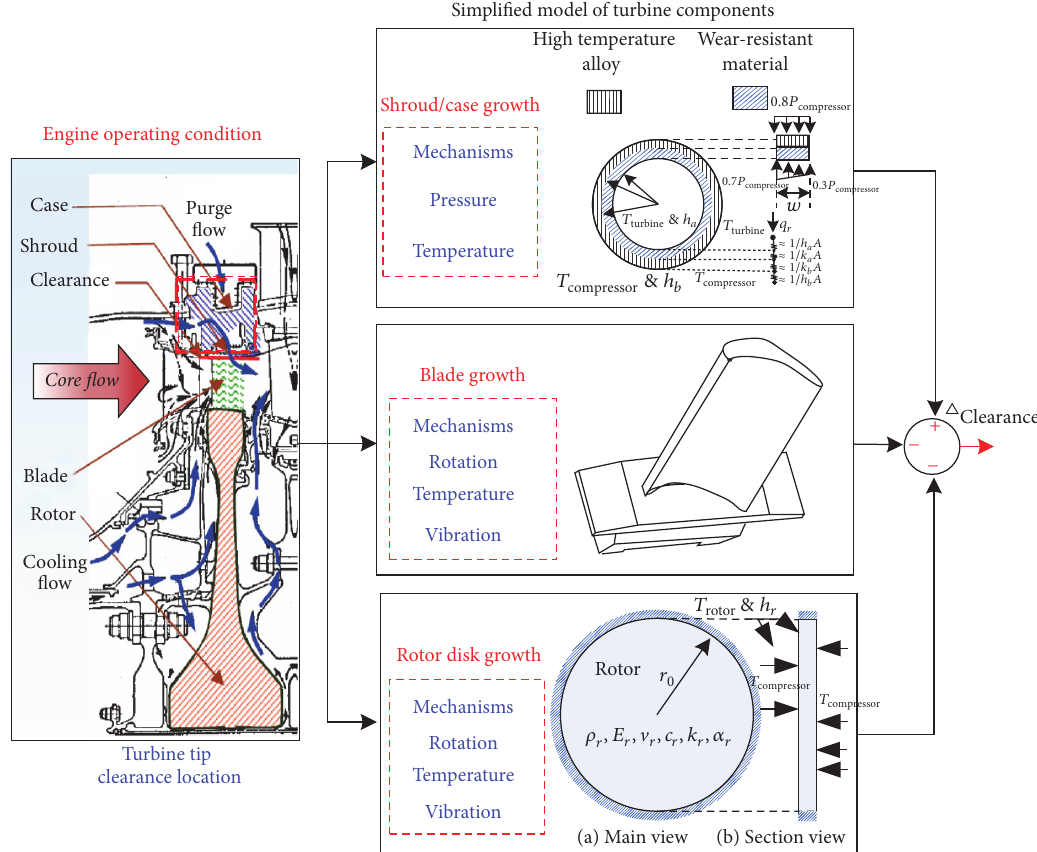
Figure 1: Model of tip clearance